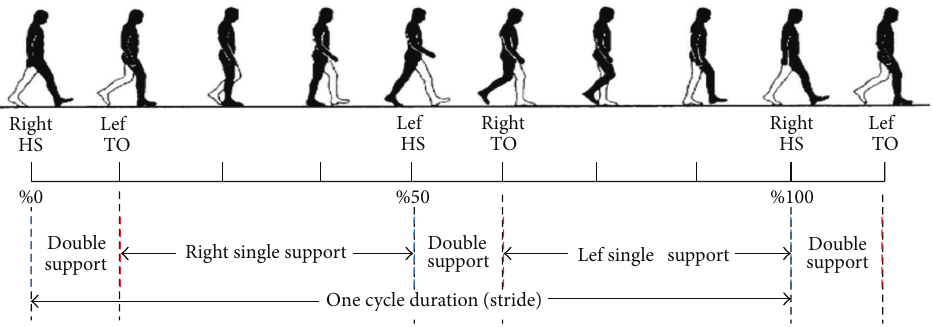
Figure 2: Human walk phases and events [19].